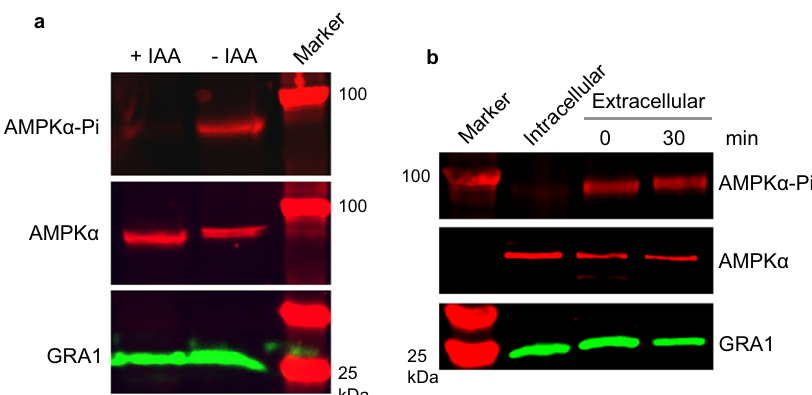
Fig. 3 | Assessment of TgAMPK α phosphorylation under different conditions. a TgAMPK α phosphorylation is abolished in TgAMPK γ depleted parasites. The AMPK γ -mAID parasites pretreated with or without IAA for 48h were forced to egress from host cells and then analyzed by Western blots, using antibodies that recognized phosphorylated AMPK α , total TgAMPK α or TgGRA1. b TgAMPK α